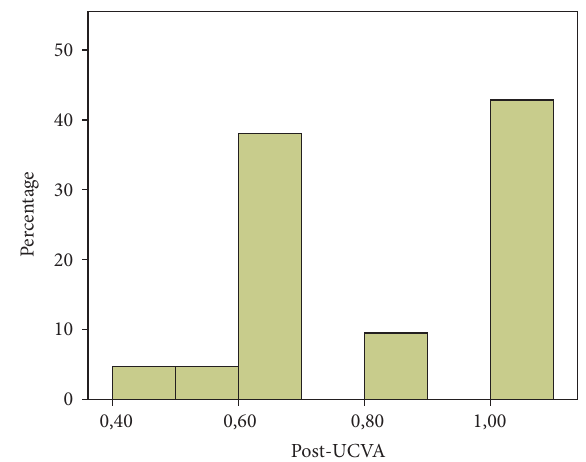
Figure 4: Refractive cylinder boxplot showing statistically signif- icant variation between preoperative and postoperative refractive cylinder values. Preoperative mean was − 1.23 D and postoperative mean was − 0.34 D. ∘ is the outlier and 3 represents the subject number 3.